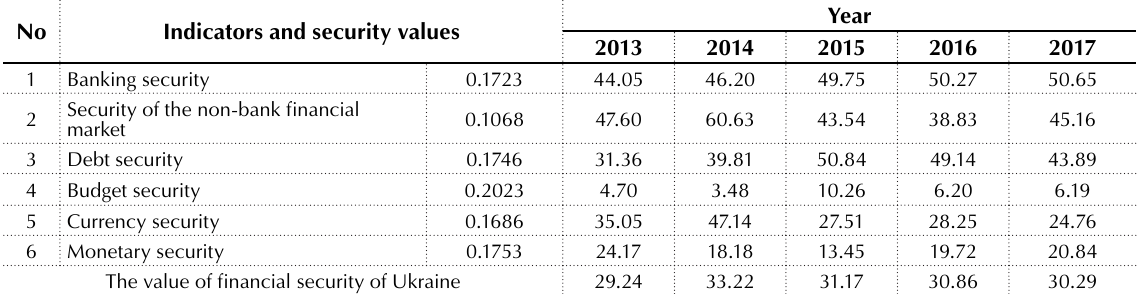
Table 4. Dynamics of the general level of financial security of Ukraine and its components in the period